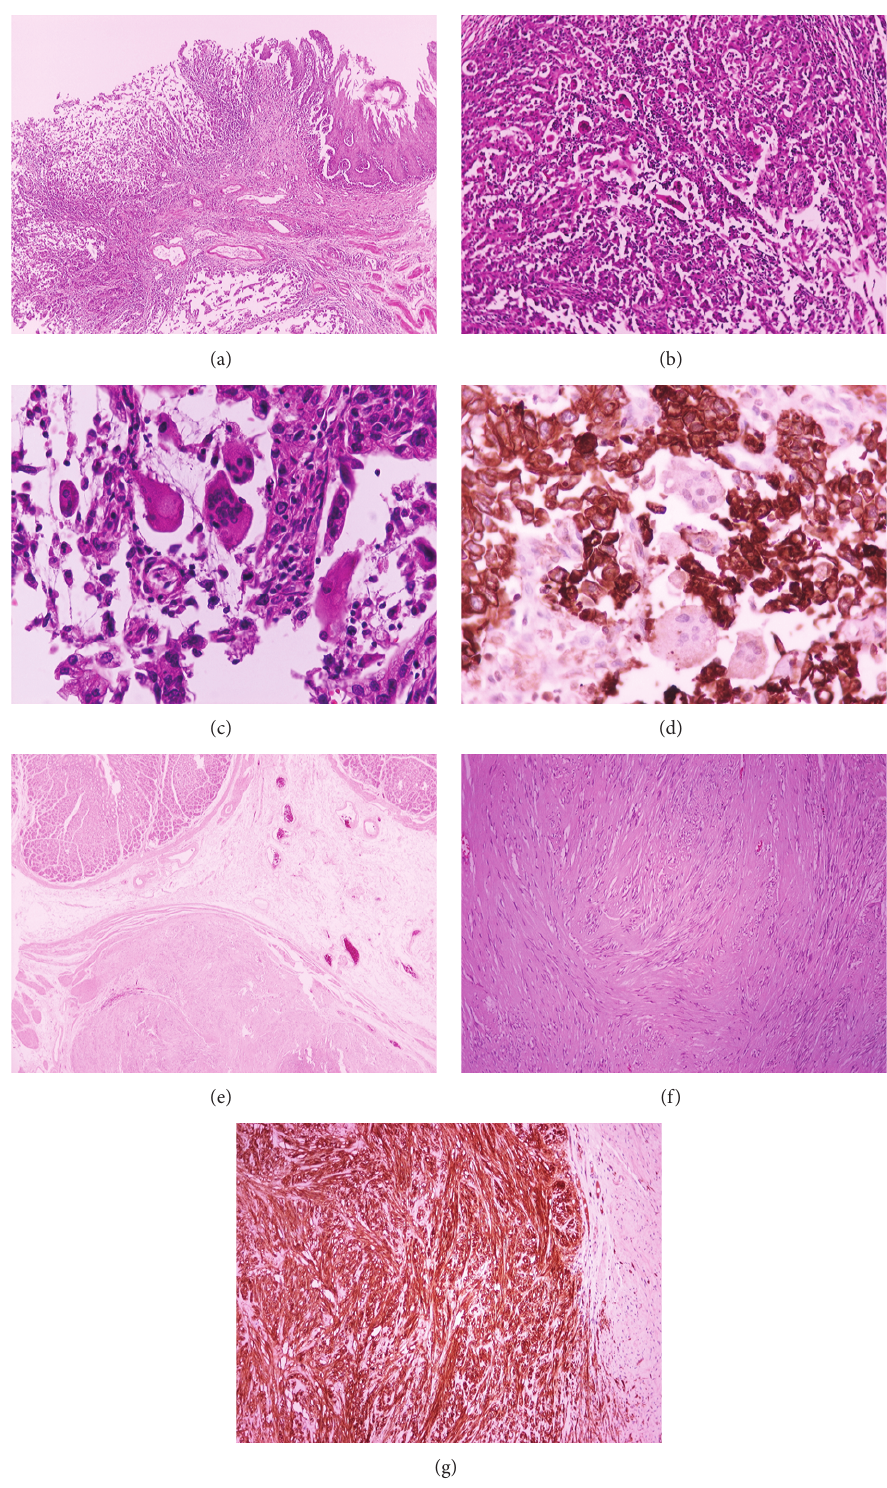
Figure 1: Poorly differentiated adenocarcinoma on gastroesophageal junction (a) with multinucleated giant cells (b), (c), which are negative to keratins AE1AE3 (d). Coincidental GIST (e), (f) positive to CD117/c-kit antigen (g). (a) H-E × 40, (b) H-E × 100, (c) H-E × 400, (d) IHC × 400, (e) H-E × 20, (f) H-E × 400, and (g) IHC ×